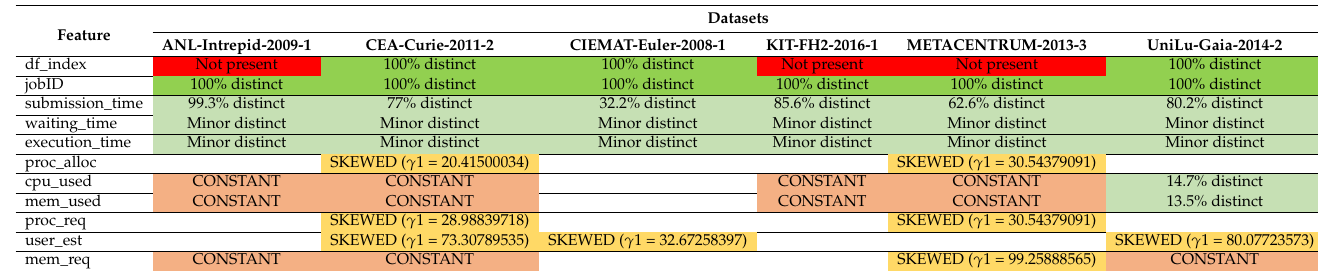
Table 7. Preliminary exploratory analysis of the chosen